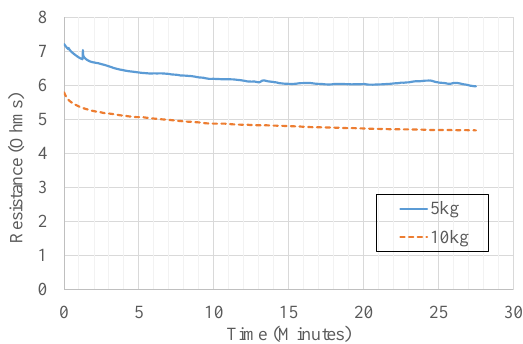
Figure 24. Experiment results: sensor drift plot—resistance change over the time.